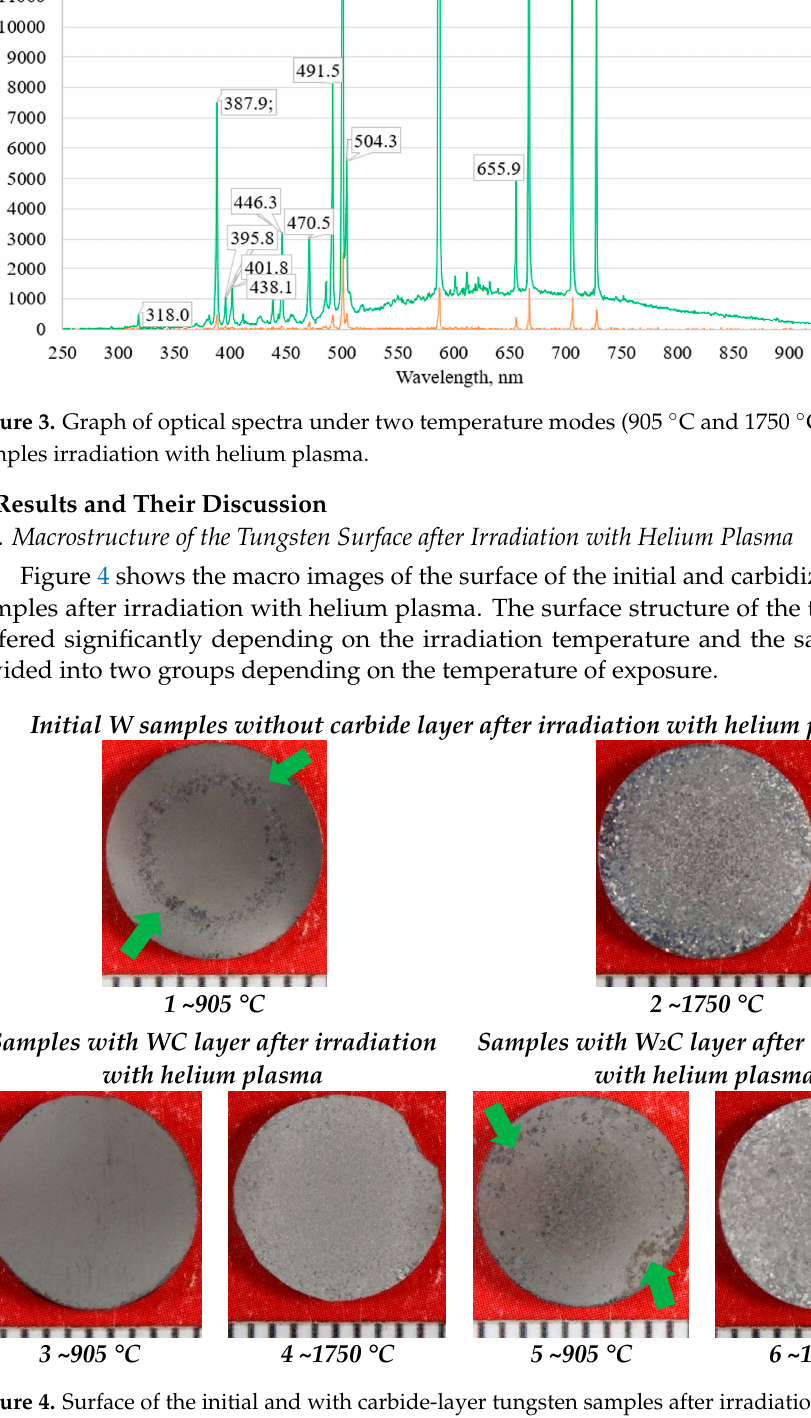
Figure 3. Graph of optical spectra under two temperature modes (905 °C and 1750 °C) of tungsten samples irradiation with helium plasma.